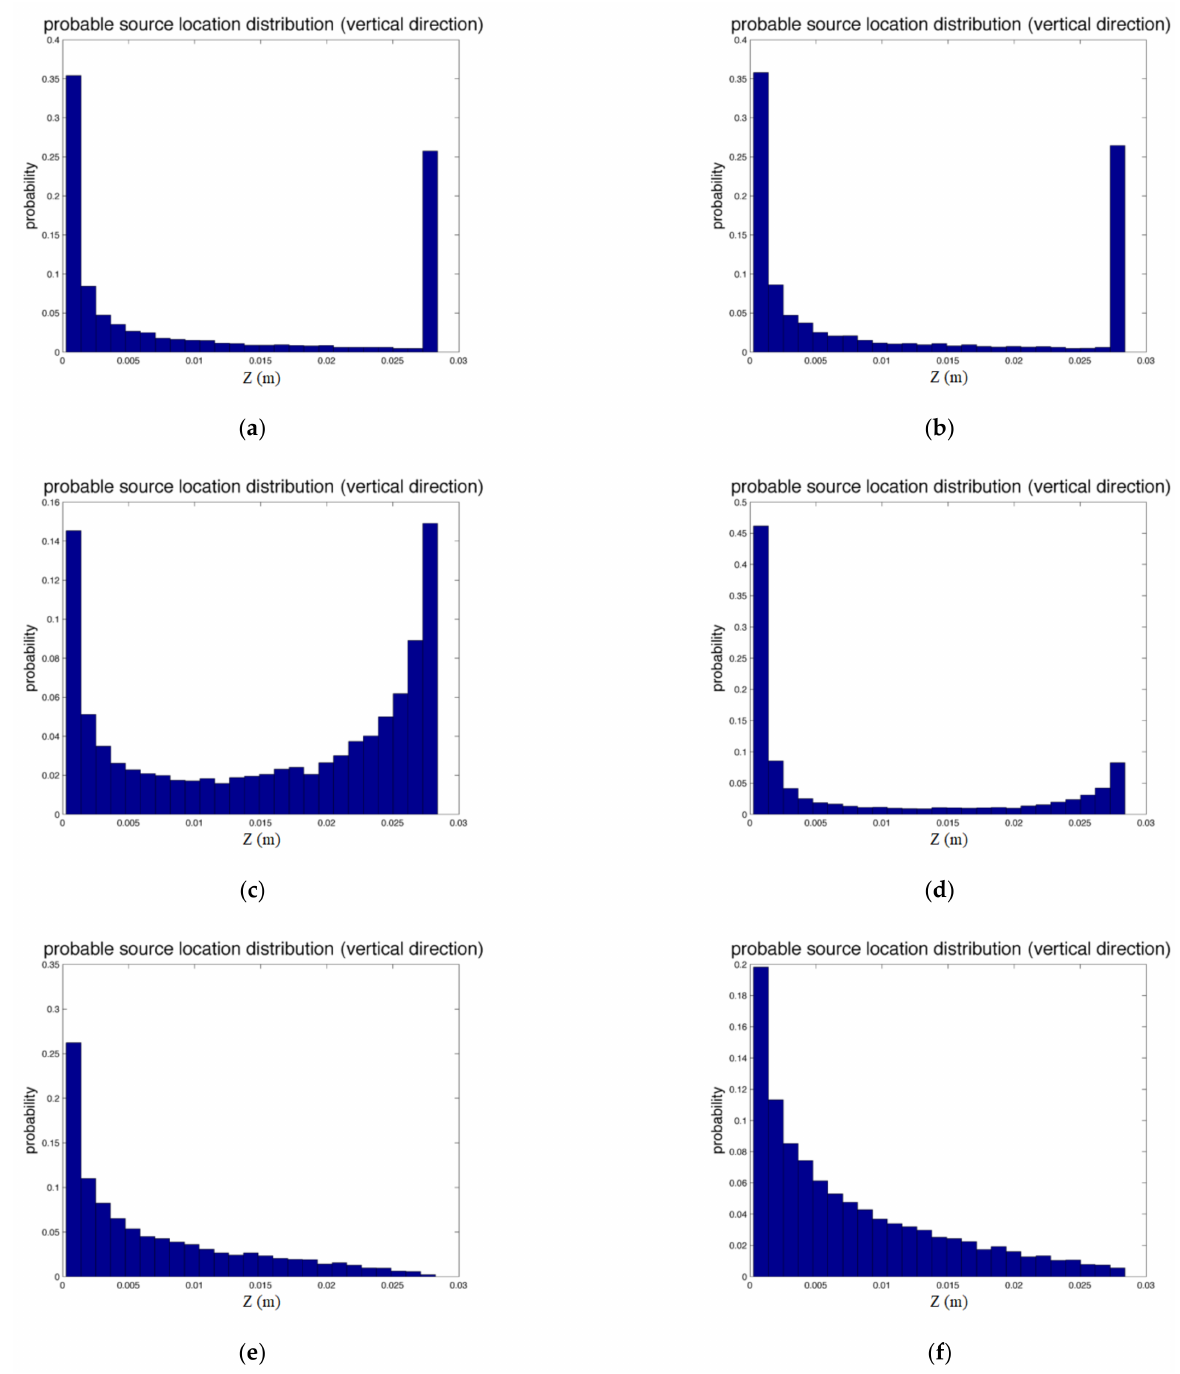
Figure 5. Final probable particle location distribution in the z-direction: ( a ) final probable source location distribution in backward tracking tests with the diffusivity of Rouse [37], using the explicit method; ( b ) final probable source location distribution in backward tracking tests with the diffusivity of Rouse [37], using the implicit method; ( c ) final probable source location distribution in backward tracking tests with the diffusivity of Absi et al. [38], using the explicit method; ( d ) final probable source location distribution in backward tracking tests with the diffusivity of Absi et al. [38], using the implicit method; ( e ) final particle location distribution in forward tracking tests with the diffusivity of Rouse [37], using the explicit method; ( f ) final particle location distribution in forward tracking tests with the diffusivity of Absi et al. [38], using the explicit